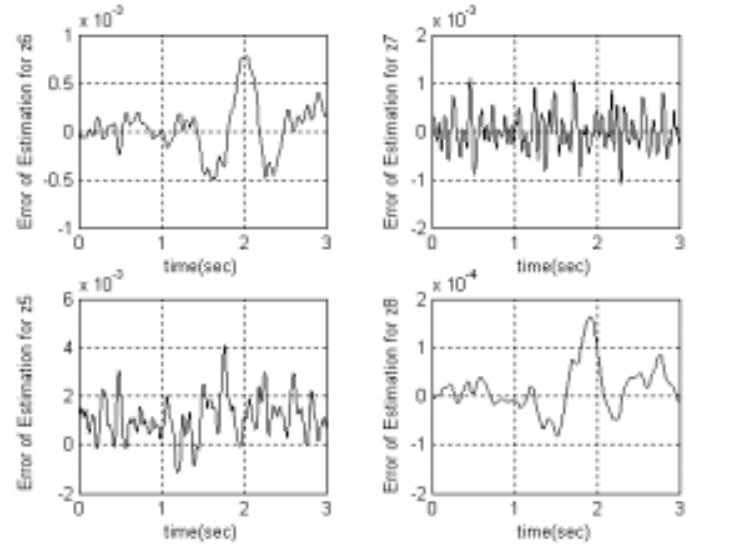
Fig. 5. Error of the estimation for the second four